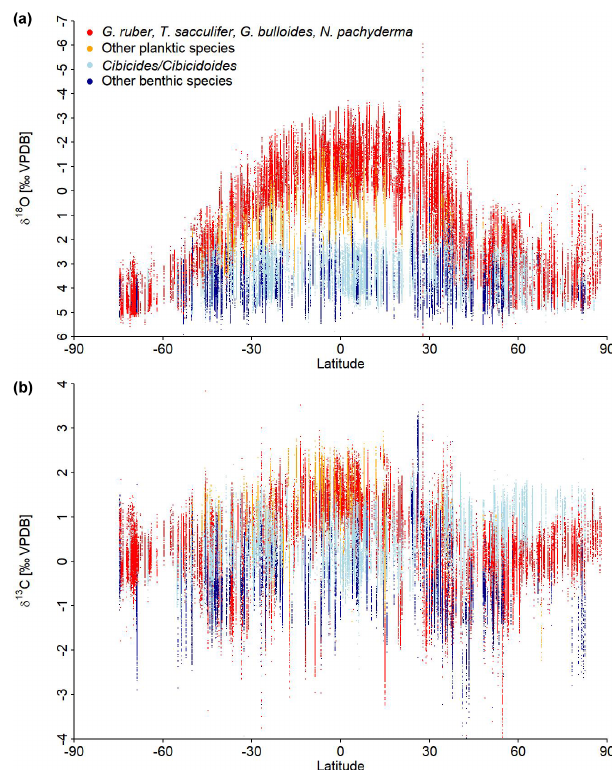
Figure 7. Distribution of δ 18 O values (a) and δ 13 C values (b) with latitude. Red/orange: planktic Foraminifera, blue: benthic Foraminifera. Extreme values outside the axis ranges are not shown.